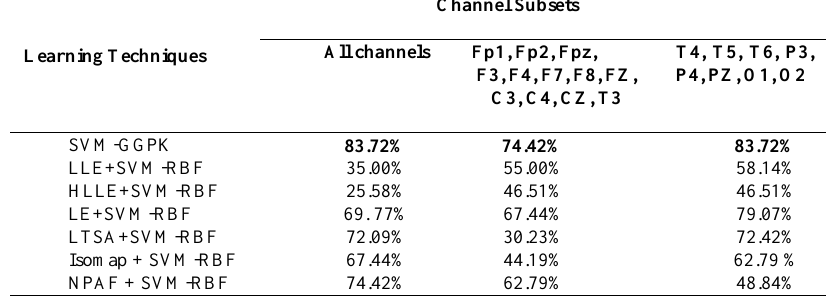
Table 5. Accuracy of SVM with RBF kernel trained on features extracted using LLE, HLLE, LE, LTSA, Isomap, and NPAF on different subsets of EEG signal of ADHD and BMD patients at eye-open resting condition. Channel